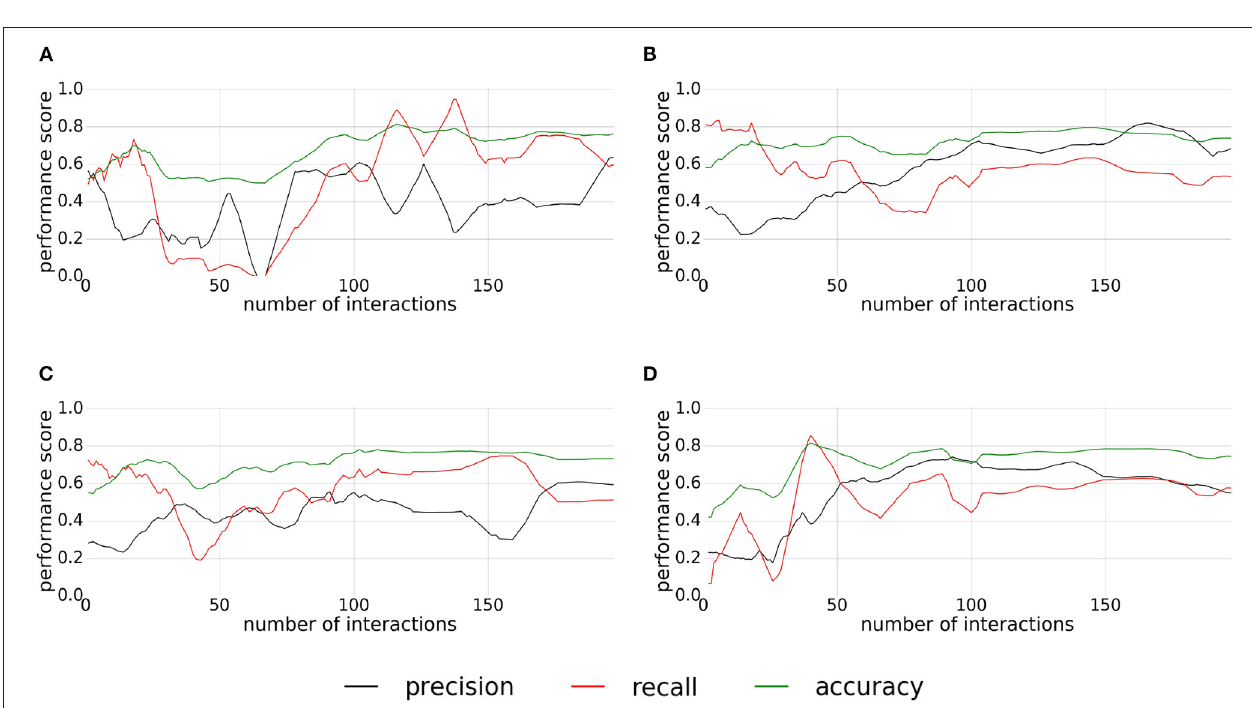
FIGURE 12 | (A–D) Plots of precision, recall, and accuracy for liftable affordance. Each plot correspond to one replication of the experiment. Figure 13 represents an affordances map obtained by the experiments described above. This map represents the areas categorized as pushable buttons in green, as liftable objects in purple, and as pushable objects in red. It was obtained by selecting